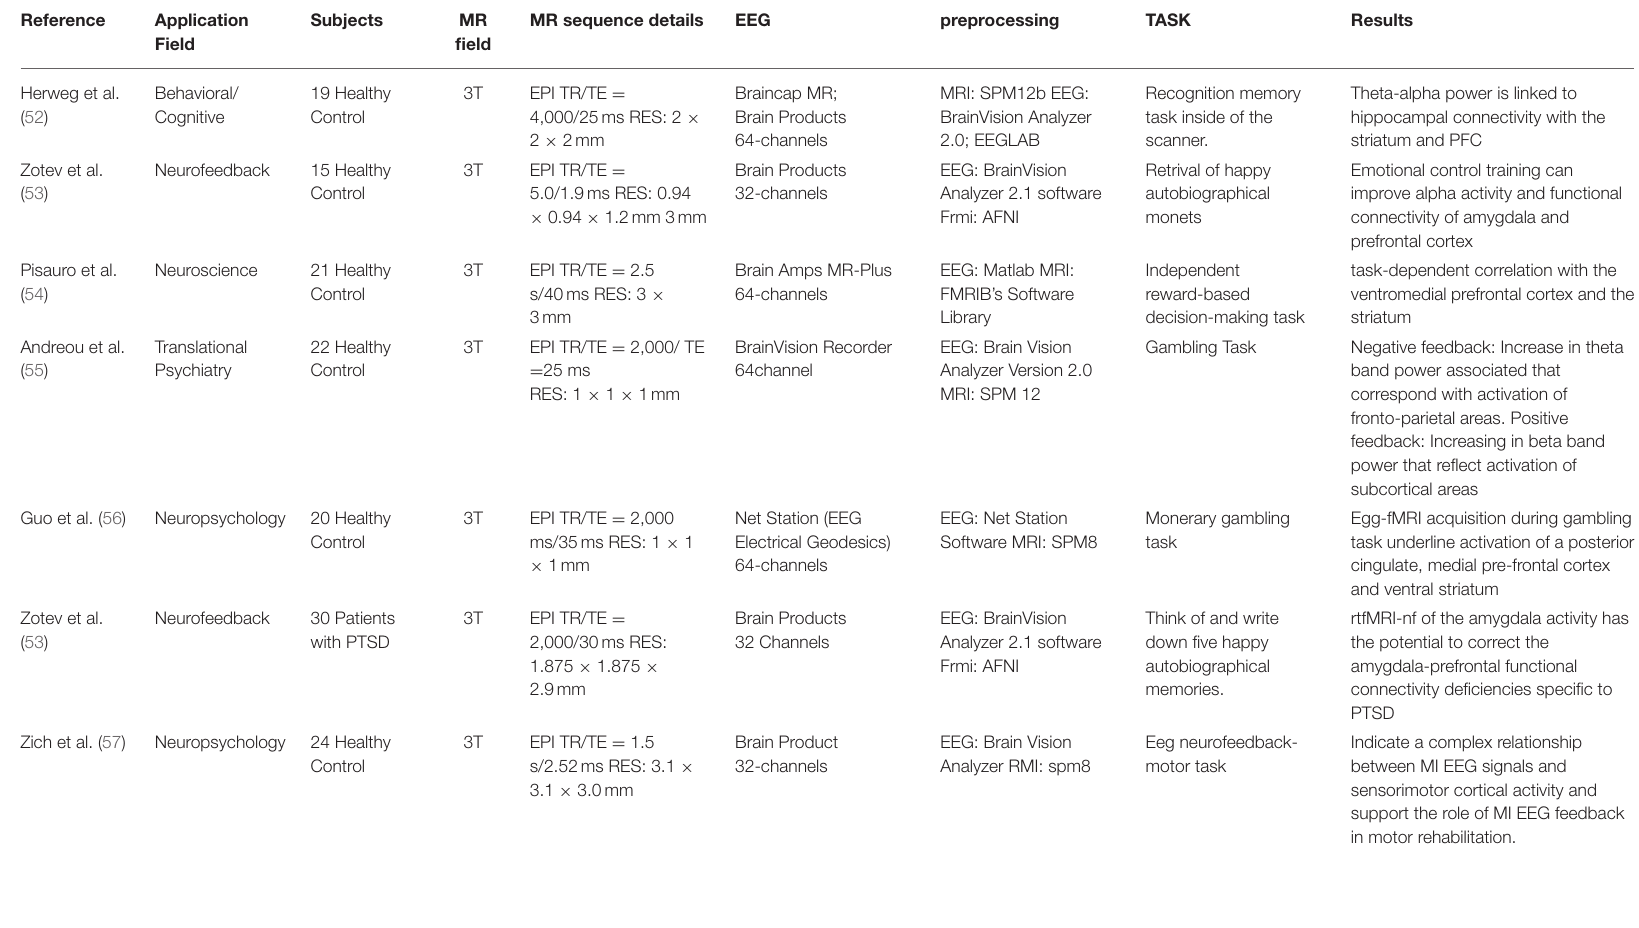
TABLE 2 | A summary of the task EEG-fMRI studies since